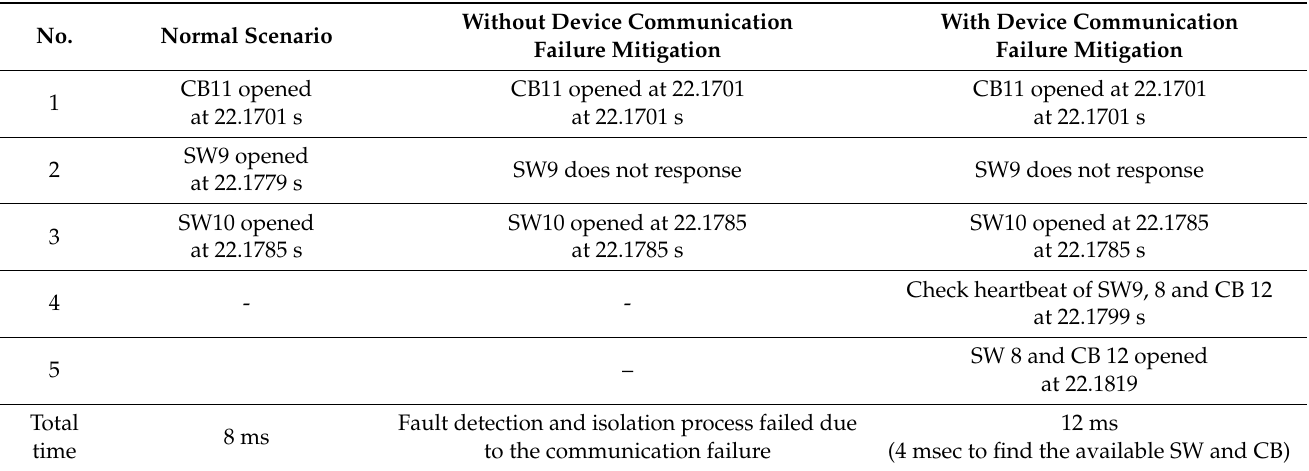
Table 4. Time measurements of fault detection and isolation process. with and without device communication failure mitigation during F-FDIR process (considering GOOSE communication